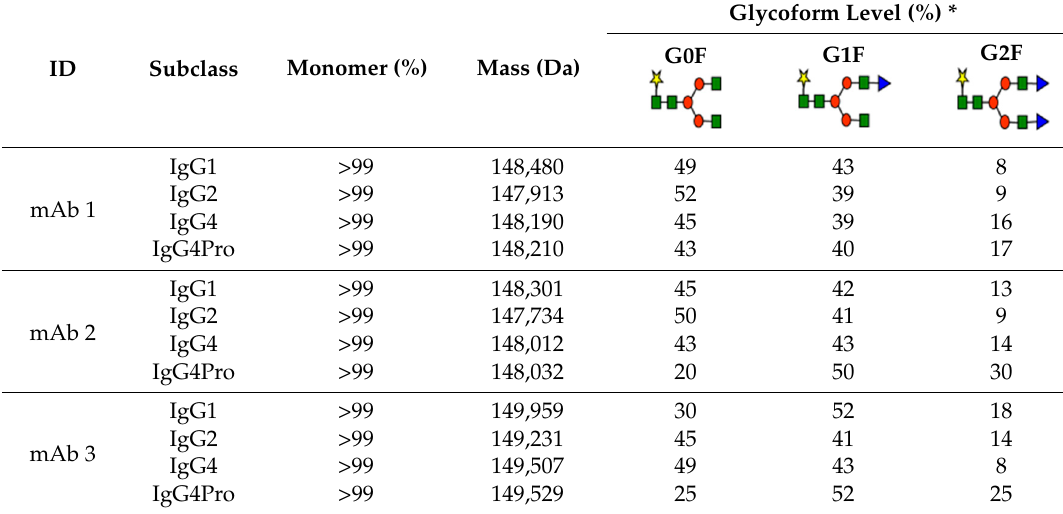
Table 1. Evaluation of IgG quality.